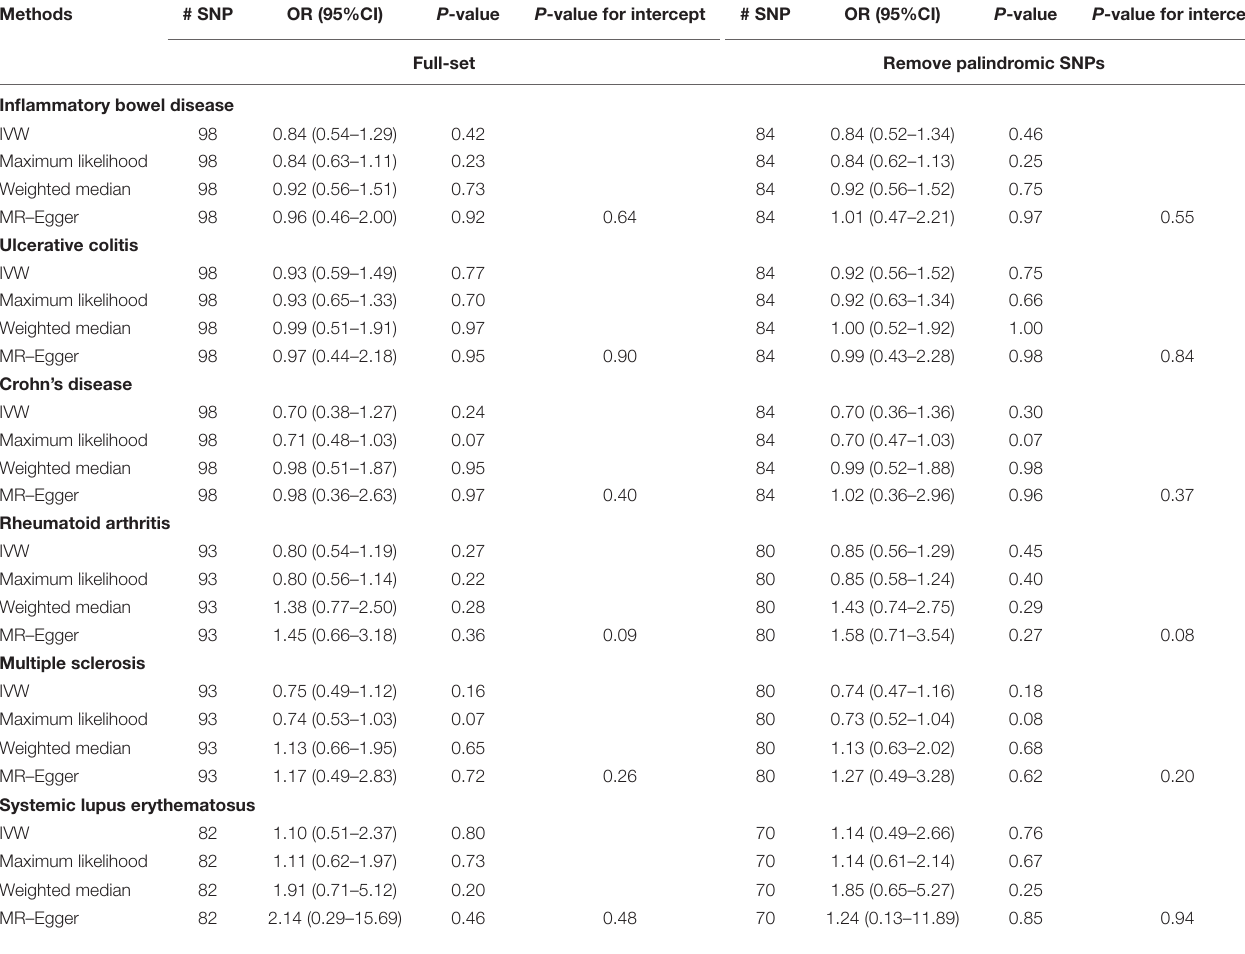
TABLE 1 | The association between genetically predicted levels of alcohol consumption and risk of common autoimmune inflammatory diseases.